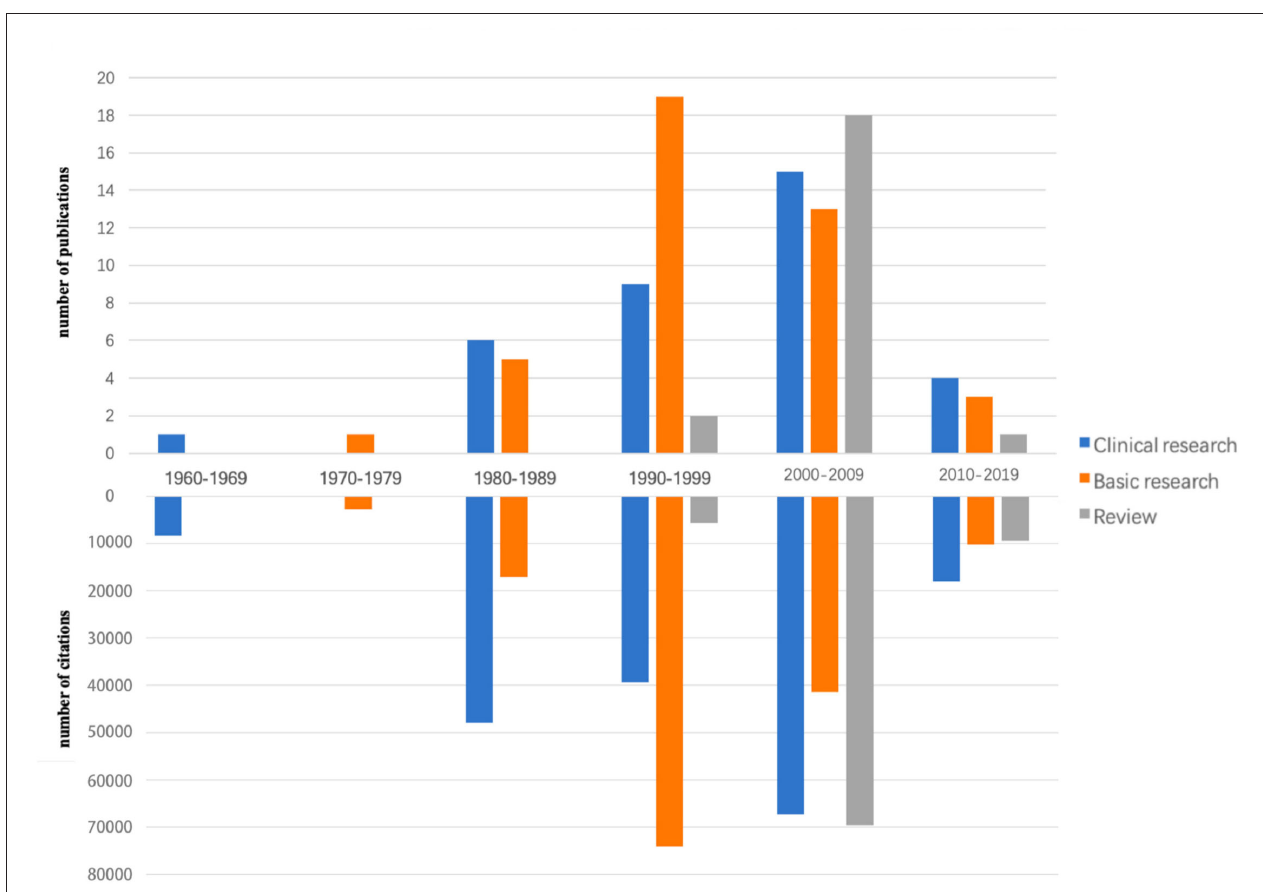
FIGURE 2 | The total number of publications and citations according to a decade in 100 top-cited articles in neurodegenerative diseases.